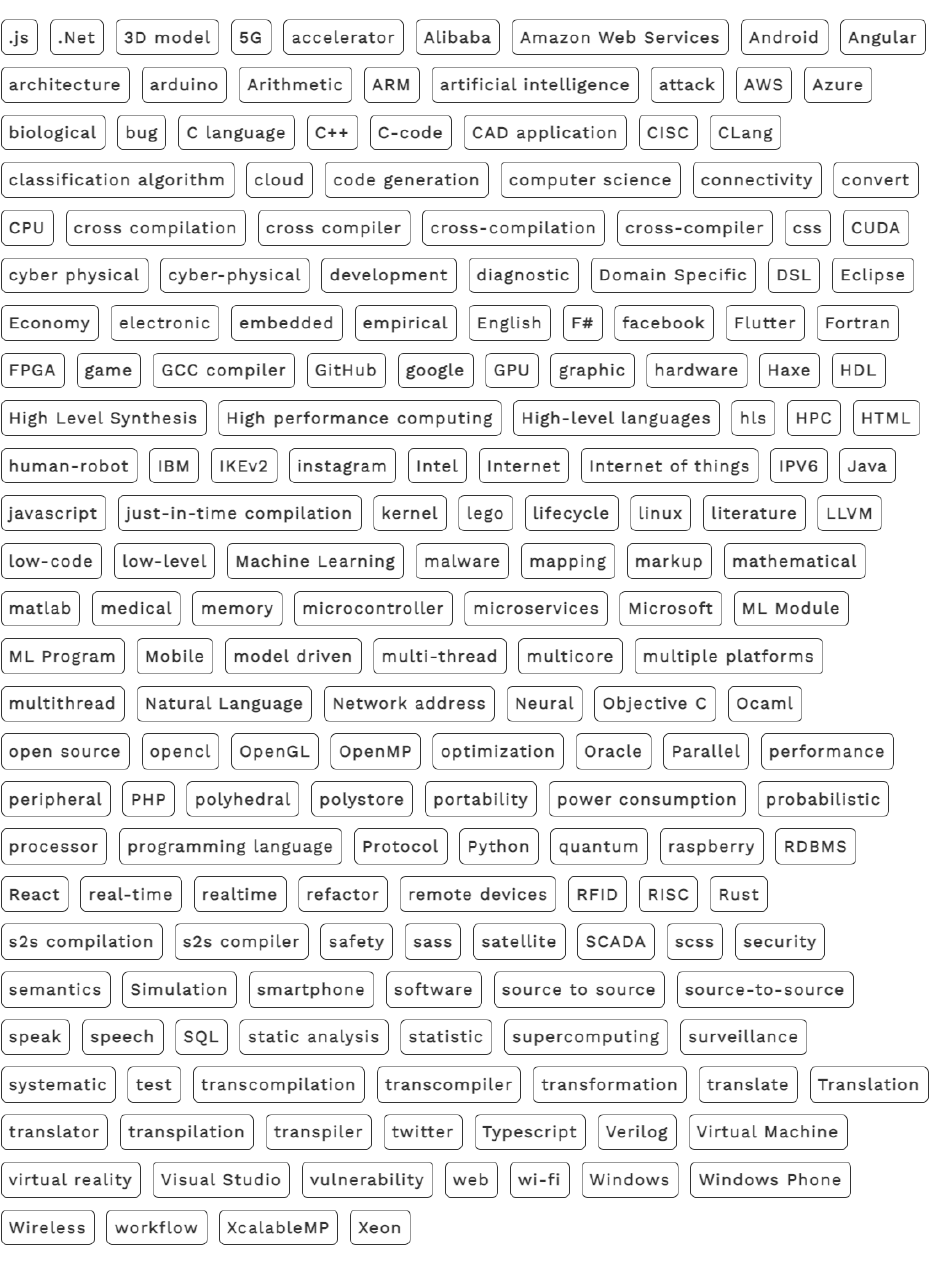
Figure 4. Considered classification